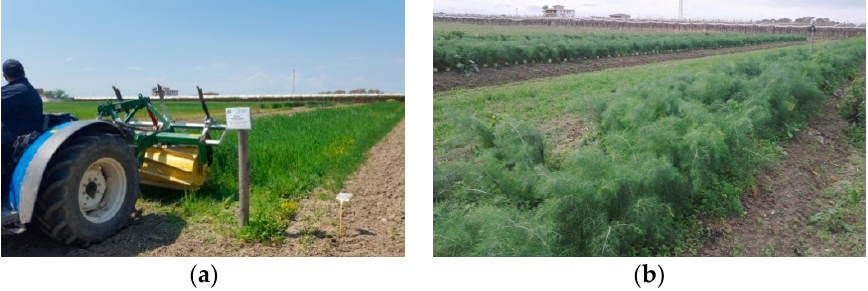
Figure 1. ( a ) Agro-ecological service crops management: termination by a roller crimper; ( b ) fennels cultivated in the raised bed and agro-ecological service crops in the flat areas (or strips). Both photos refer to the long-term field experiment “MITIORG”, which has been used to develop and test our qualitative multi-attribute decision model, DEXi-met, (research farm of the CREA- Research Centre for Agriculture and Environment, in southern Italy).